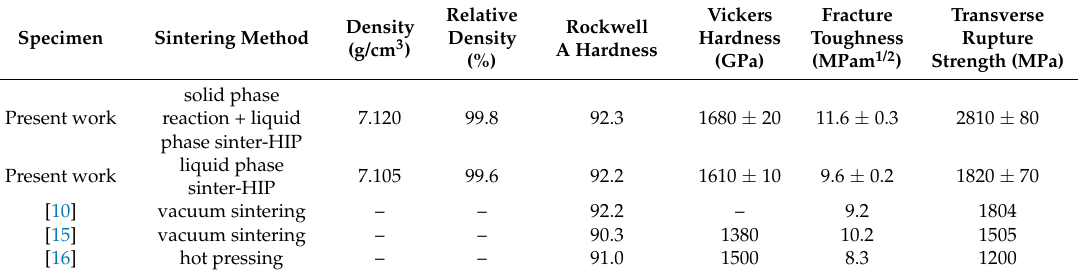
Table 1. Properties of Ti(C,N) cermets prepared by solid phase reaction and sinter-HIP.